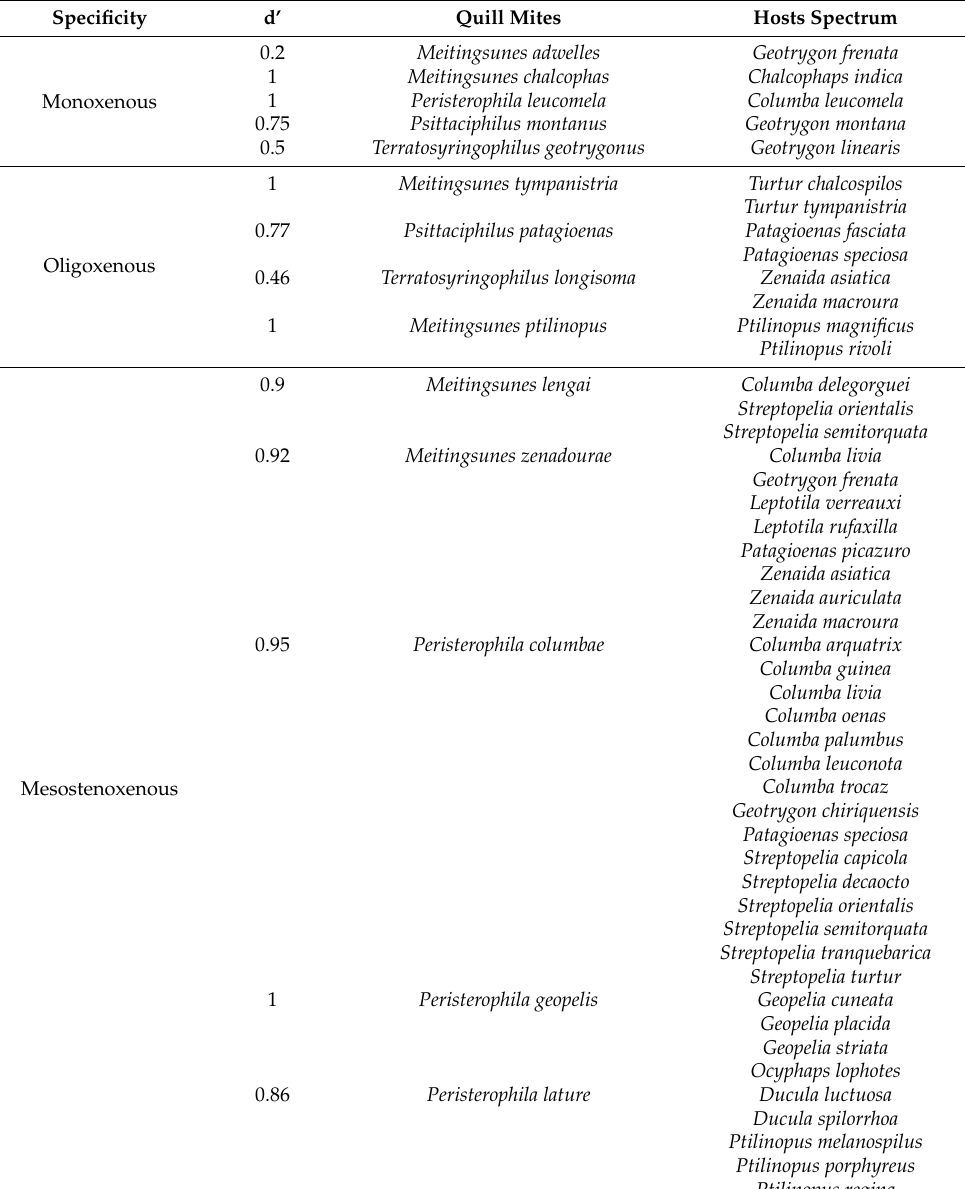
Table 3. Host specificity of quill mite species of the subfamily Syringophilinae with the value of d’ index. Specificity d’ Quill Mites Hosts Spectrum